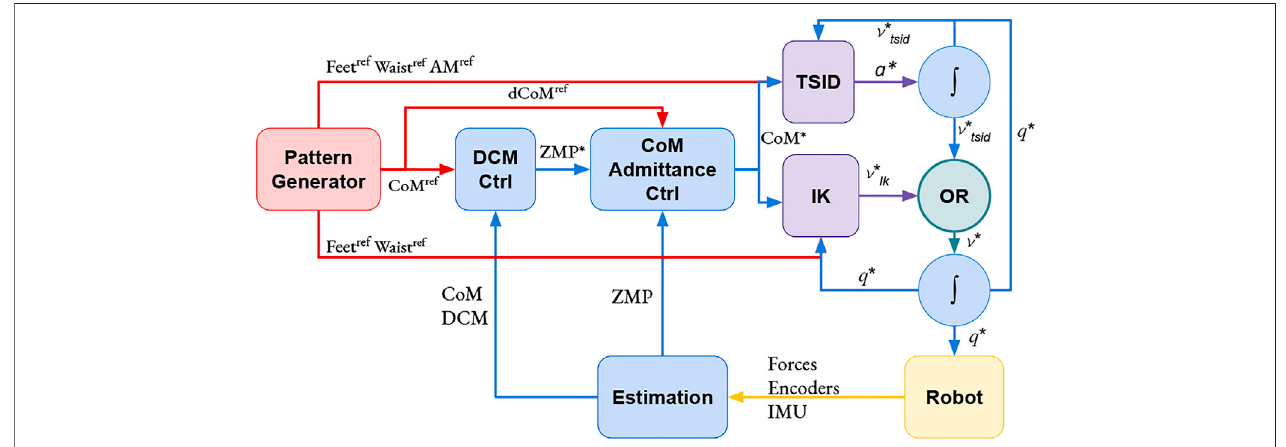
FIGURE 2 | Position control schemes: IK and TSID. The OR block is used to activate only one controller at a time.